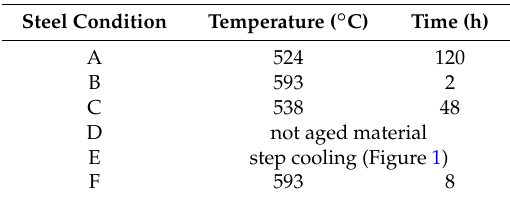
Table 2. The investigated steel’s aging conditions.